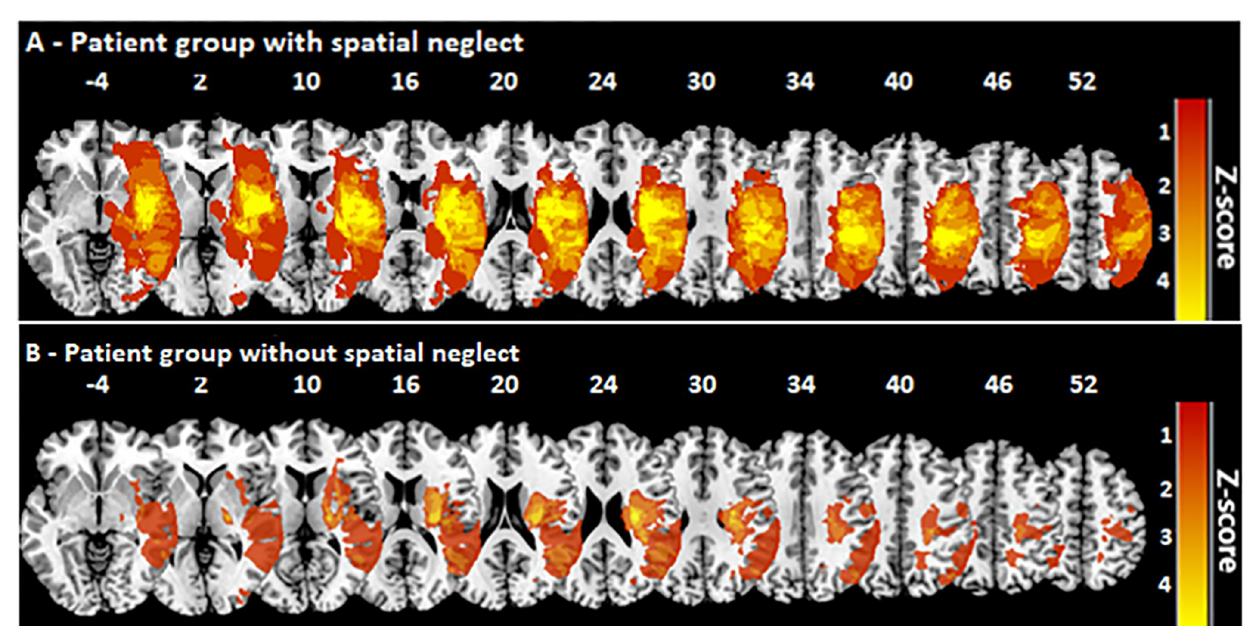
Fig 2. Overlap of the normalized lesions of the two right brain damaged patient groups. The lesion maps were superimposed on the single-subject T1 MNI152 template. For each voxel, the number of patients with a lesion at that location is color coded. The vertical z coordinate for each slice of standardized MNI space is